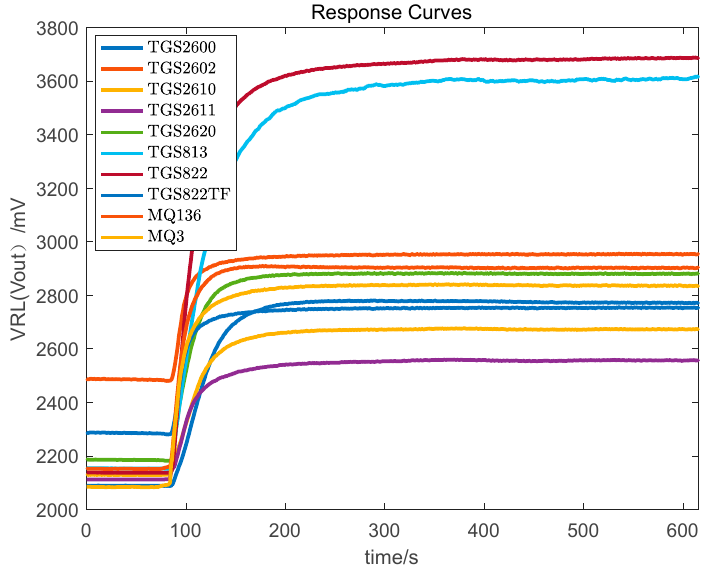
Figure 2. Data acquisition process of Chinese liquors based on electronic nose.